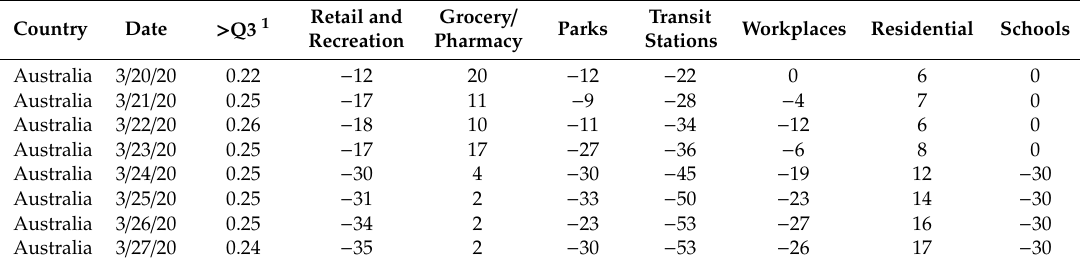
Table 2. Dataset abstracted from UNESCO [16] and Google reports [15].